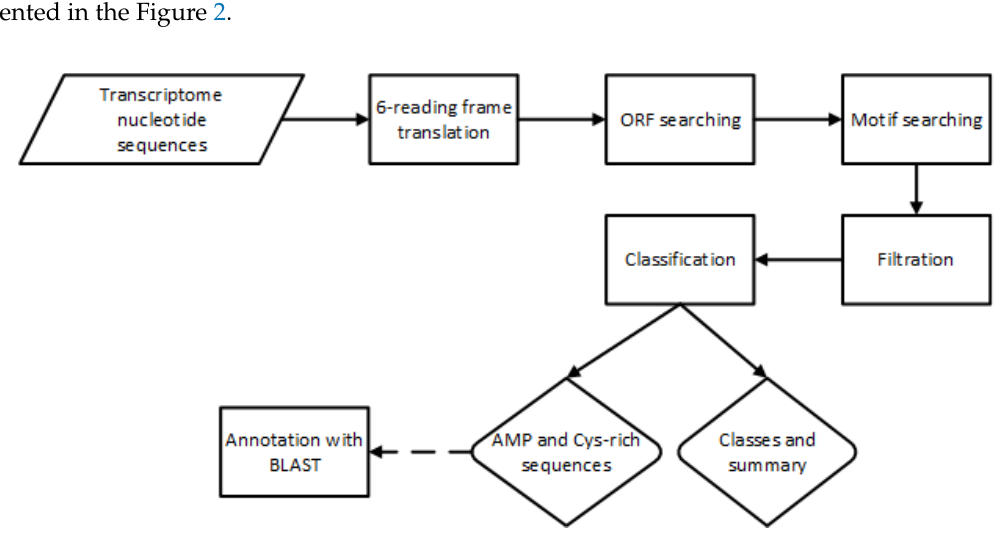
Figure S1: Alignment of all sequences containing DEF06 motif., Table S1: Distribution of potential AMPs revealed by Cysmotif searcher pipeline among plant families and